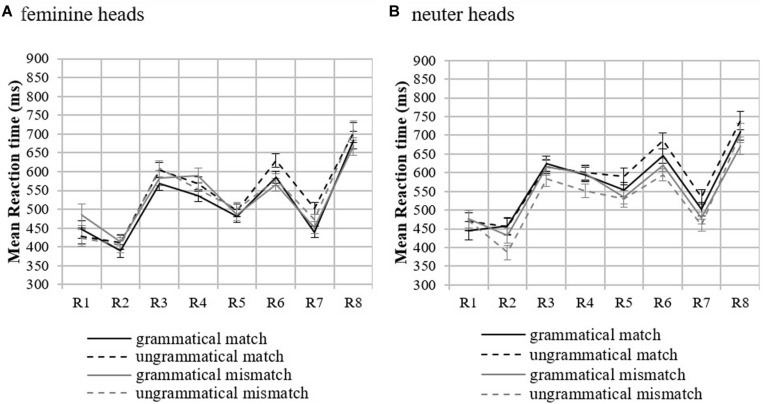
Mean reaction time by condition in feminine (A) and neuter (B) heads in Experiment 2. Error bars indicate the standard error of the mean across participants. R on the x-axis stands for Region. Region 3: Head, Region 4: Attractor, Region 5: Agreement target (past-participle), Region 6: first post-critical region, Region 7: second post-critical region and Region 8: sentence-final region.